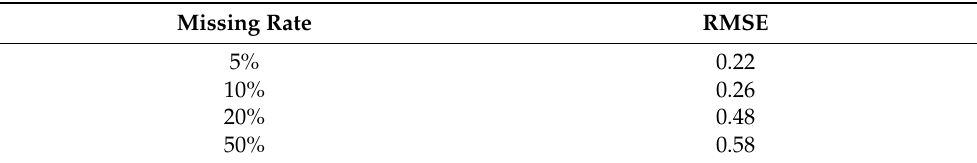
Table 1. Root mean square error (RMSE) of the original data and the projected data under different data missing rates.